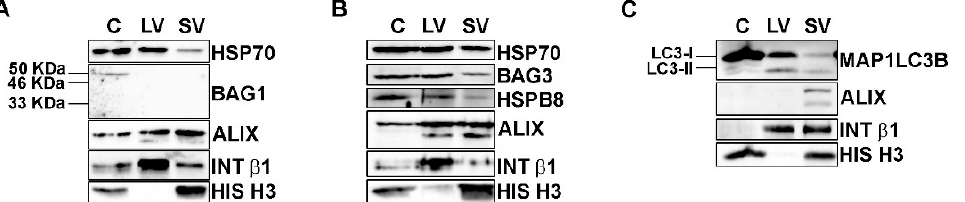
Figure 2. EVs contained HSP70-associated PQC system components. ( A – C ) Representative WB analysis of cellular, LVs and SVs samples derived from NSC-34 cells grown in basal conditions showed the presence of HSP70, BAG3, HSPB8 and MAP1LC3B proteins. ( A ) WB showed HSP70 in all samples, whereas its co-chaperone BAG1 was not detected in EVs. ( B ) HSP70, BAG3 and its partner HSPB8 were present in all samples. ( C ) WB analysis showed that cells are enriched in the MAP1LC3B-I form, whereas EVs contained both the MAP1LC3B-I and its lipidated form, MAP1LC3B-II.